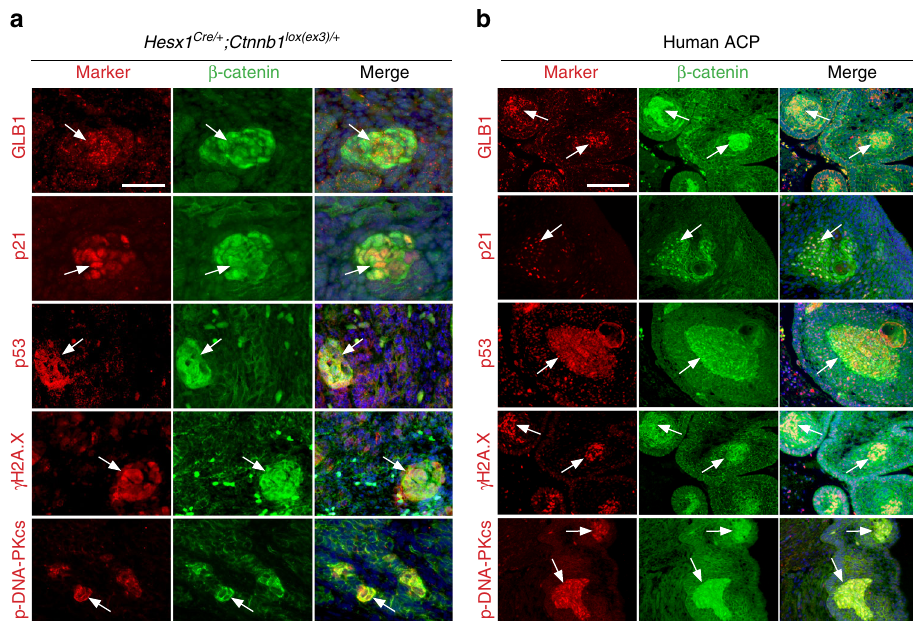
Fig. 2 β -catenin-accumulating cluster cells in mouse and human ACP express senescence markers. Double immunostaining on histological sections of Hesx1 Cre/ + ;Ctnnb1 lox(ex3)/ + pre-tumoural pituitaries at 18.5 dpc ( a ) and human ACP tumours ( b ). Note that cluster cells (arrows) express lysosomal enzymes such as GLB1, encoding senescence-associated β -galactosidase, the cell cycle regulators p21 and p53, as well as the DNA damage and DNA damage response markers gamma histone 2AX and phospho-DNA-PKcs, respectively. Results are representative from experiments conducted in six to eight mice and 23 human ACP tumours. Normal brain was used as negative control. Scale bars: a 50 μ m; b 100 μ